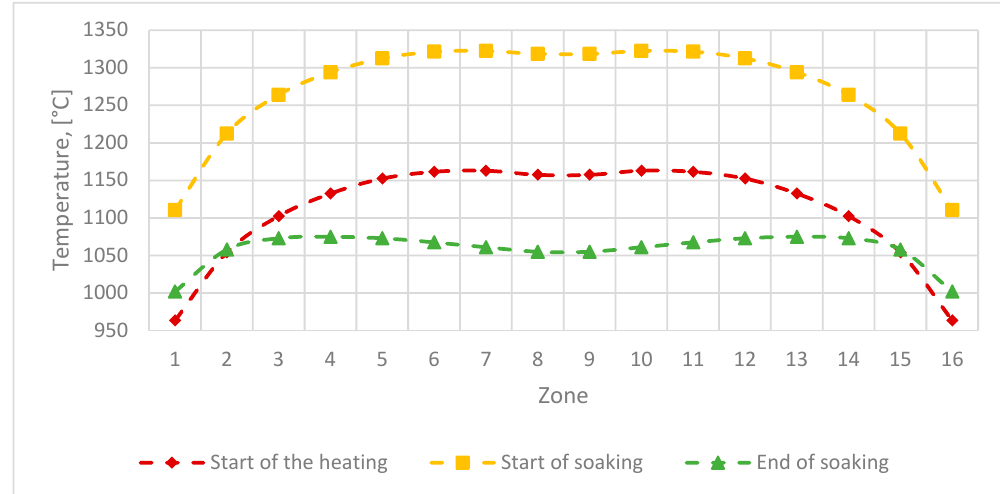
Figure 13. Change in the temperature differential across the zones of the furnace with a change in thermal power (for the case with K rec = 2). The time of changing the heating parameters from the red to the yellow line is the first heating period; from yellow to green is the second.